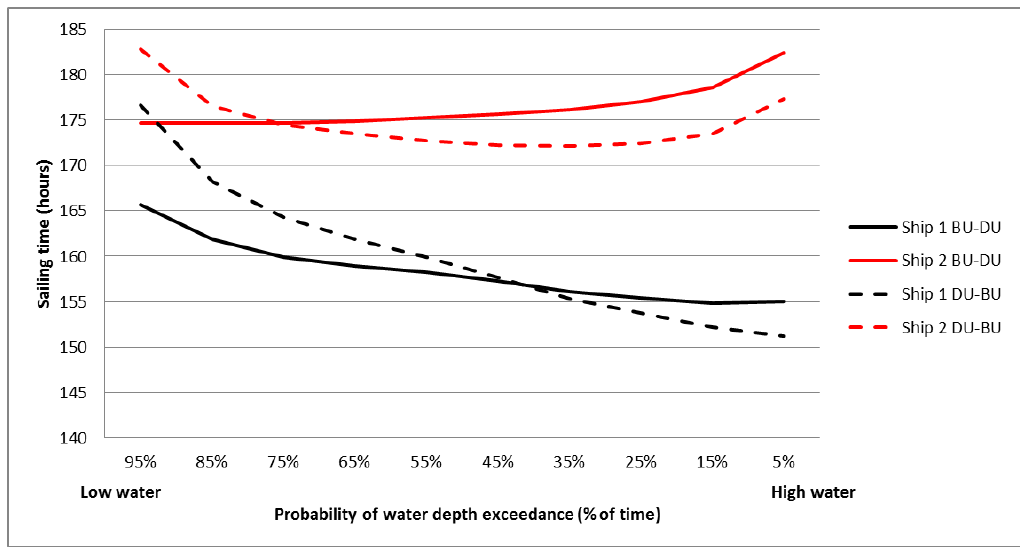
Figure 6. One-way sailing times - sensible